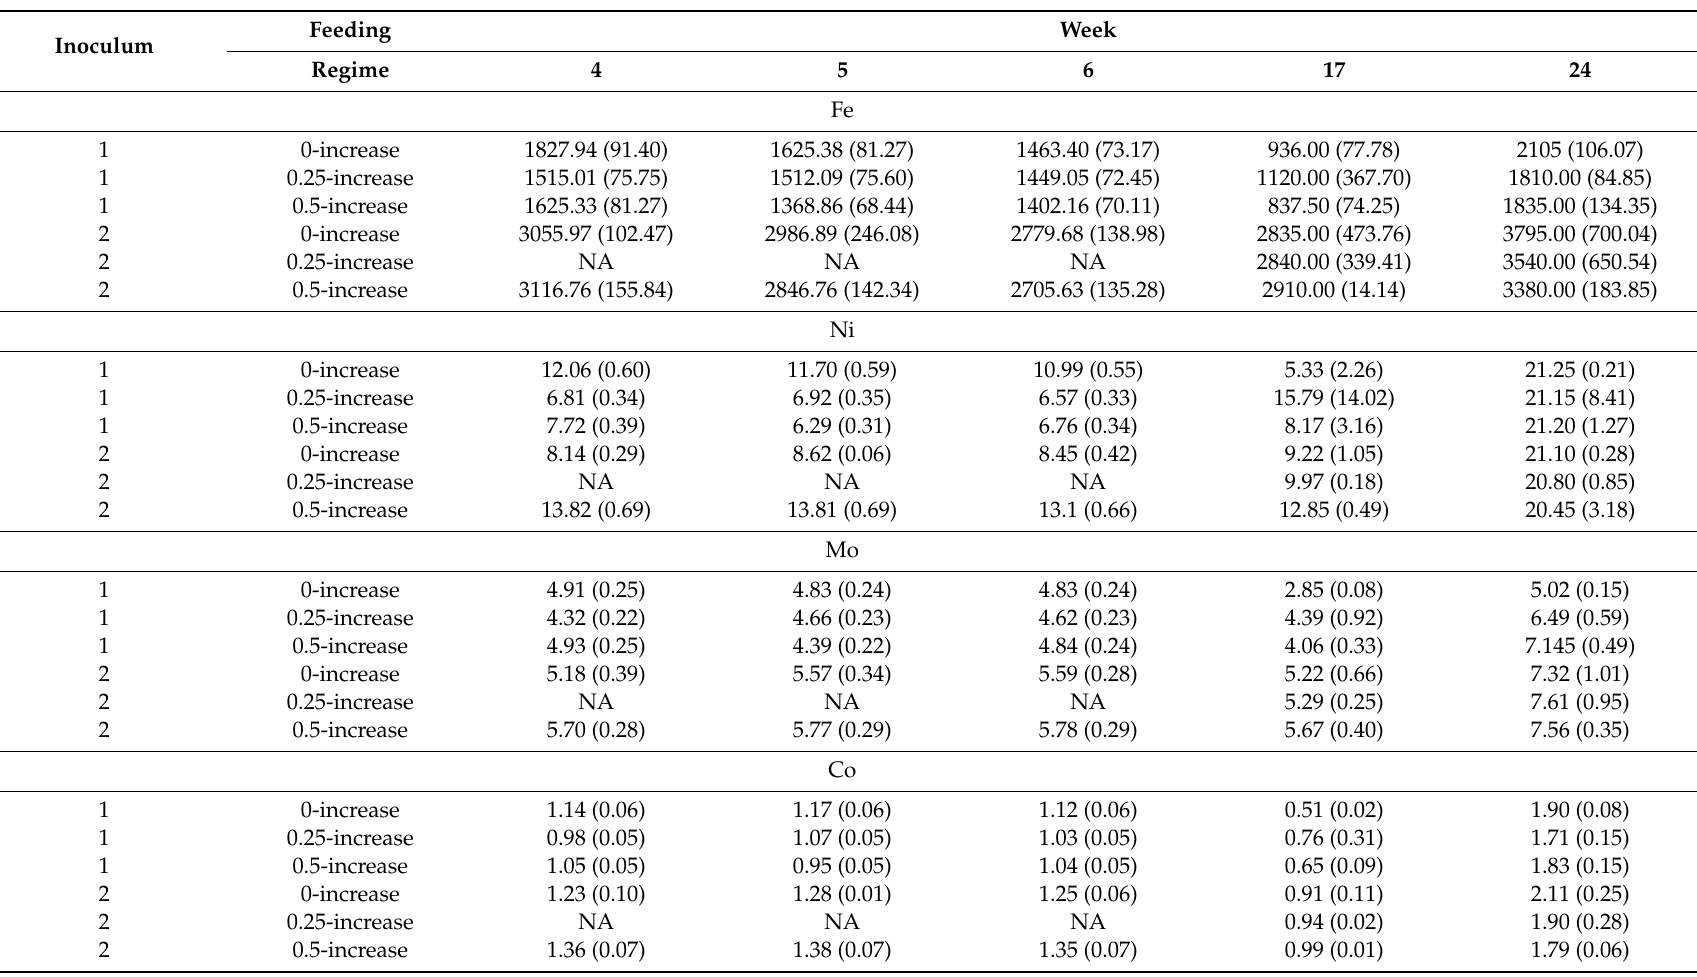
Table 3. Concentrations of trace elements in the reactors over the trial period, in mg · kg − 1 related to dry matter. Feeding regime expresses the N-increase rate in a feeding ratio. Values are given as mean; standard deviation is given in